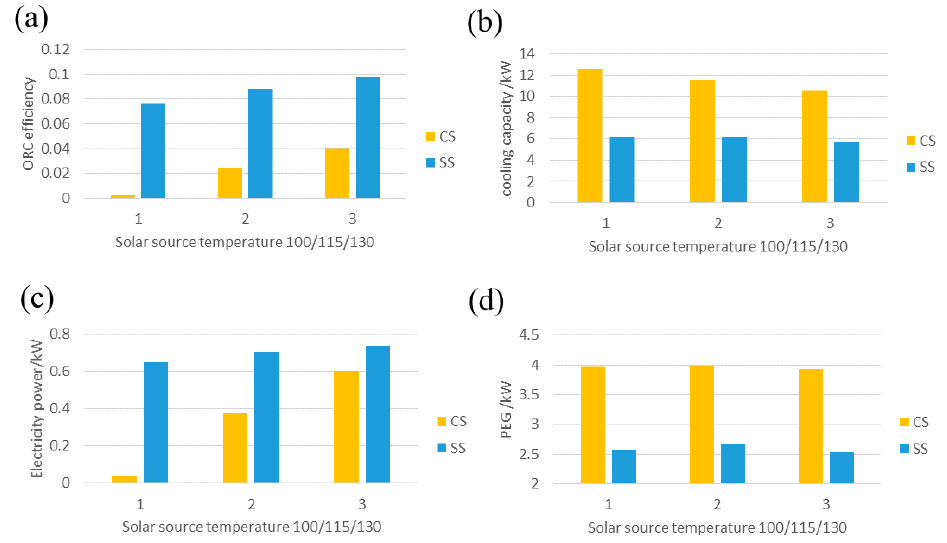
Figure 5. ( a ) ORC efficiency, ( b ) cooling output capacity, ( c ) electricity generation and ( d ) primary energy efficiency for the CCHP systems under different solar collecting temperature with R1233zd as ORC working fluids in cooling mode.